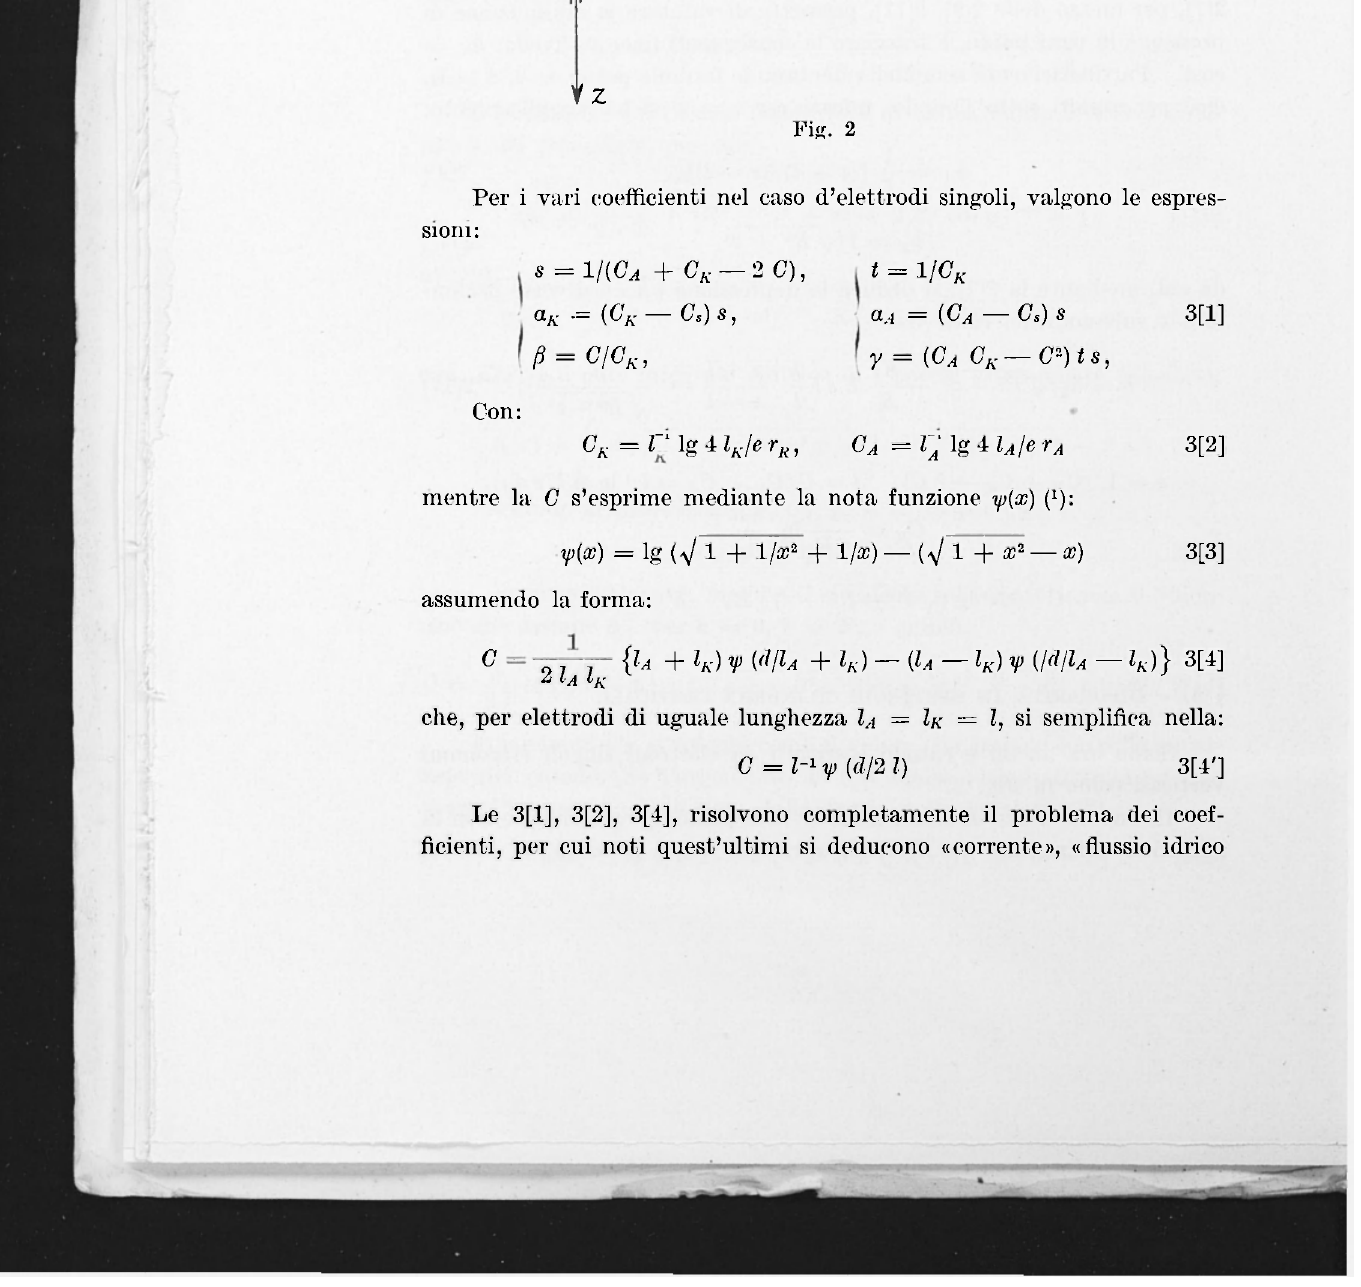
Per i vari coefficienti nel caso d'elettrodi singoli, valgono le